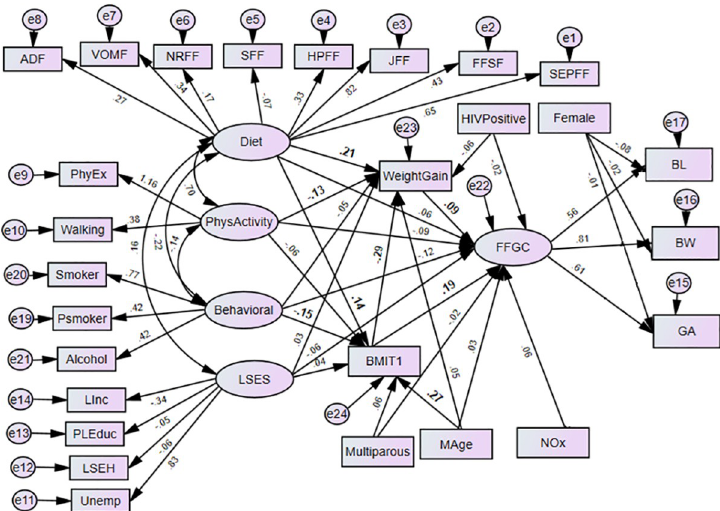
Fig 3. Prenatal maternal exposure characteristics on birth outcomes (BW, BL, GA) through FFGC, gestational weight gain and pre-gestational BMI (Model 3) BW-Birthweight; BL-Birth Length; GA- Gestational Age; NOx- Oxides of Nitrogen; GWG- Gestational Weight Gain; BMIT1- Pre-gestational BMI; and Mage- maternal age. Latent variables: dietary factors (EFSF- energy foods and snacks; FFSF-spreads and fast foods; JFF- junk foods factor; PRFF-protein-rich foods; SFF- starch foods; NRFF-nuts and rice foods; VRFF-vegetable-rich foods; and ADF- alcoholic drinks); PhyEx- physical exercise; PSmoker- passive smoker; LSES -low socio-economic status, Linc- Low income; PLEduc- primary or less education; LSEH-Low socio-economic housing; Unemp- unemployed.